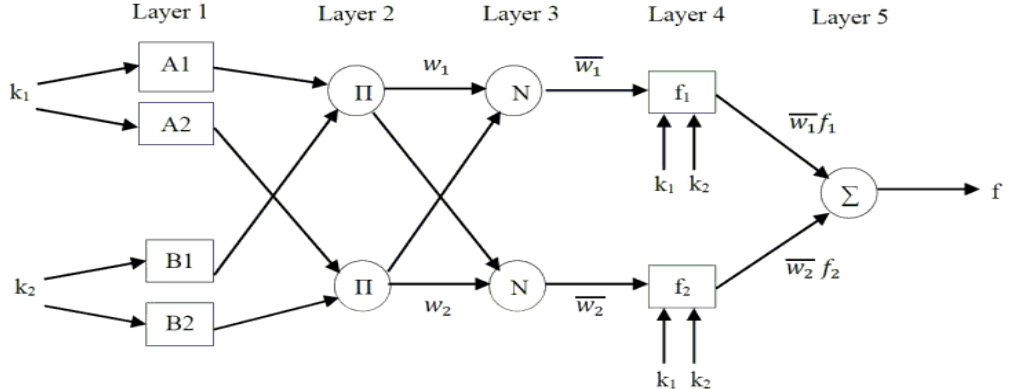
Figure 3. Adaptive Neuro-Fuzzy Inference system structure.